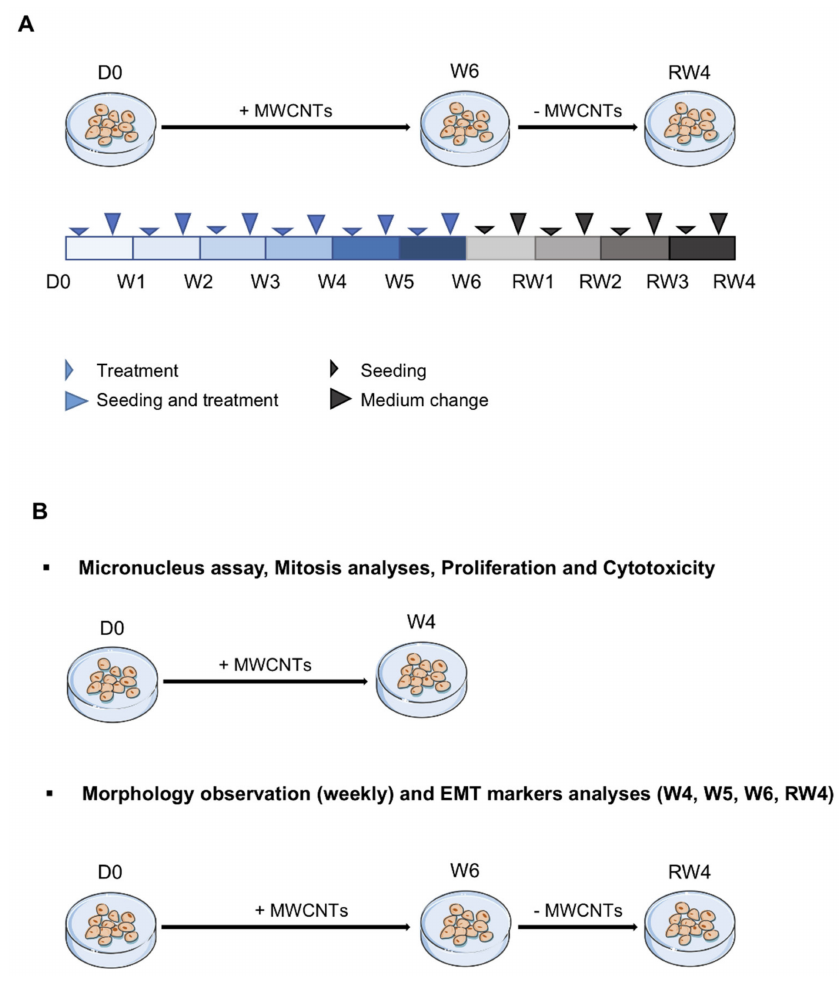
Figure 1. Scheme of the treatment schedule for BEAS-2B cells. ( A ) The cells were seeded at 3500 cells/cm 2 on day 0. Cells were treated with 0.125, 0.25 and 0.5 µ g/cm 2 of Mitsui-7 or 0.25, 0.5 and 1 µ g/cm 2 of NM-403 twice a week for 6 weeks followed by 4 weeks without treatment. ( B ) Micronucleus assay, abnormal mitoses, cell proliferation and cytotoxicity were evaluated the first four weeks (W1 to W4). Cell morphology was observed weekly from the 1st week of treatment to the 4th week of the recovery period. Analysis of EMT markers using RT-qPCR and Flow Cytometry was conducted after 4 to 6 weeks of treatment (W4 to W6) and after the 4th week of the recovery period (RW4). EMT: epithelial-mesenchymal transition, RW: recovery week, W: